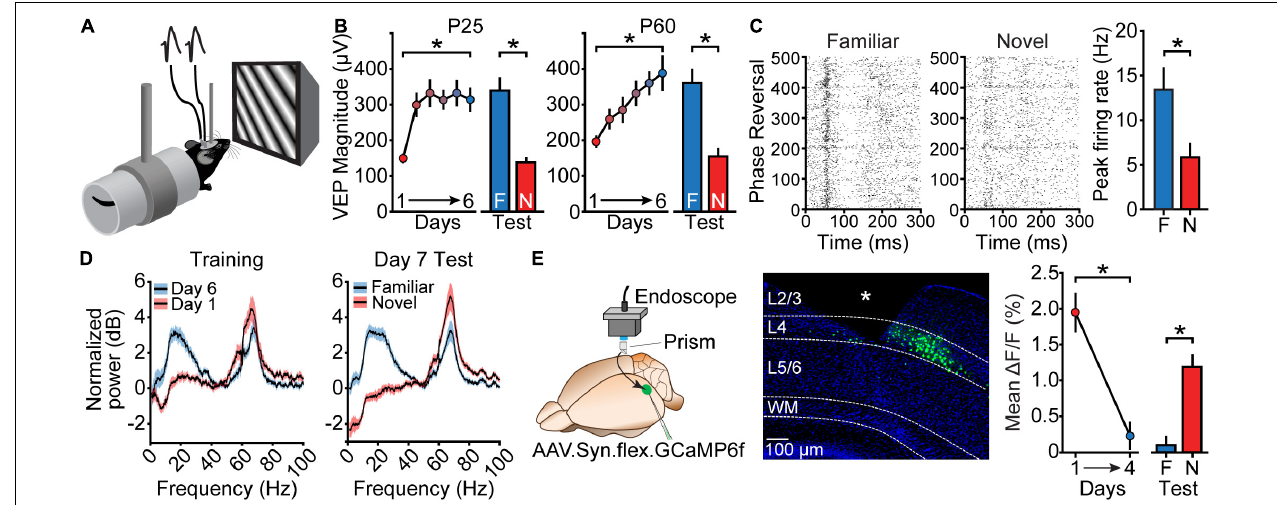
FIGURE 1 | Manifestations of stimulus-selective response plasticity (SRP). (A) In a standard SRP experiment, mice are chronically implanted with tungsten microelectrodes in L4 of the binocular region of V1. They are then head-fixed and passively view black-and-white phase-reversing grating stimuli in order to elicit visually-evoked potentials (VEPs). (B) In juvenile (P25) mice, a single day of stimulus presentation leads to substantial potentiation of the VEP, which is maintained across subsequent days of viewing. The VEP elicited by a novel (N) stimulus orientation on the test day is reduced relative to the VEP elicited by the familiar (F) orientation. Adult (P60) mice require several days to reach asymptotic SRP, but after 6 days of stimulus presentation display a F / N difference similar to that of juvenile mice. Replotted from Schecter et al. (2017). (C) SRP also manifests as an increase in the peak firing rate of multi-unit activity recorded from L4 of V1. As with VEPs, the peak firing rate is potentiated for the familiar orientation relative to the novel orientation. Replotted from Cooke et al. (2015). (D) SRP is also apparent in changes in the spectral power of various oscillation frequencies. Relative to familiar stimuli, novel stimuli elicit greater high-frequency (gamma) oscillations and diminished low-frequency (alpha/beta) oscillations. This can be observed as a difference in the normalized power within these frequency ranges both when comparing the first and last days of SRP induction, and when comparing responses to familiar and novel orientations presented within the same session. Replotted from Hayden et al. (2021). (E) SRP manifests as a decrease in the activity of L4 principal cells when measured with calcium imaging during blocks of F stimuli. Mice expressing GCaMP6f in L4 principal cells are implanted with a prism, and a 1-p microscope is used to measure cellular fluorescence during SRP induction. Average dF/ F responses decrease over the course of SRP induction, and are greater when viewing novel stimuli relative to familiar stimuli. White asterisk in this panel indicates location of implanted prism. (cid:49) F / F calculated as F stim – F gray / F gray . Replotted from Kim et al. (2020). Black asterisks throughout this figure indicate significant